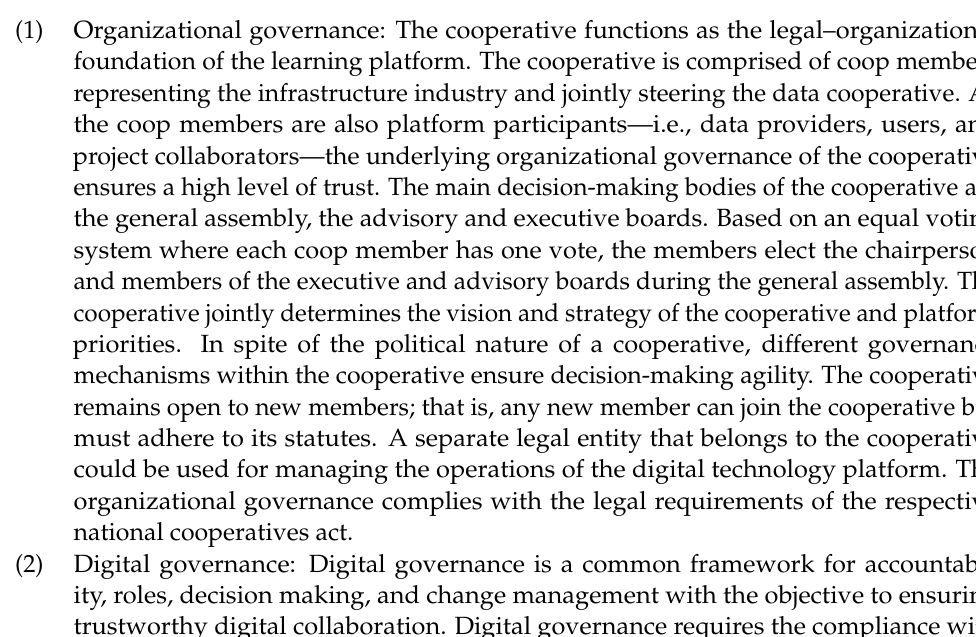
Figure 8. Types of governance for trustworthy digital collaboration (authors’ own research and depiction) .